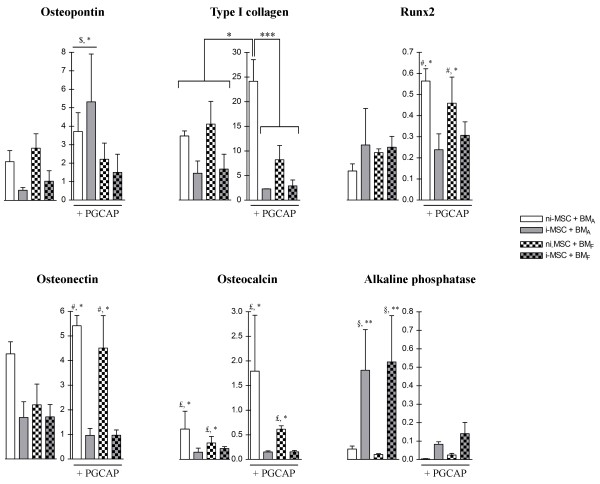
PGCAP improves osteogenic differentiation of mesenchymal stromal cells (MSCs) loaded on biomaterials. Total RNAs were extracted from ni-MSCs and i-MSCs loaded on BMA and BMF at high cell seeding density (200 × 103 cells per biomaterial) embedded or not in PGCAP and grown for 21 days. Quantifications of osteopontin, type I collagen, Runx2, osteonectin, osteocalcin, and alkaline phosphatase mRNA expression were analyzed by real-time quantitative-polymerase chain reaction. Transcript levels in arbitrary units are expressed as mean ± standard error of the mean. A statistically significant difference between individual conditions or groups of condition was revealed by analysis-of-variance test followed by Student Newman-Keuls test. Osteopontin: group of ni-MSCs and i-MSCs loaded on BMA embedded in PGCAP was compared with other conditions ($*P <0.05). Type I collagen: individual comparisons, *P <0.05, **P <0.01, ***P <0.001. Runx2, Osteonectin: group with ni-MSCs embedded in PGCAP (loaded in both biomaterials) was compared with other conditions with i-MSCs (#*P <0.05). Osteocalcin: comparison of group osteogenic-induced or not (£*P <0.05). Alkaline phosphatase: group with i-MSCs without PGCAP (loaded in both biomaterials) was compared with other conditions with ni-MSCs (§**P <0.01). i-MSC, not osteogenic induced-mesenchymal stromal cell; ni-MSC, not induced-mesenchymal stromal cell; PGCAP, platelet glue obtained from cryoprecipitation of apheresis platelet products.